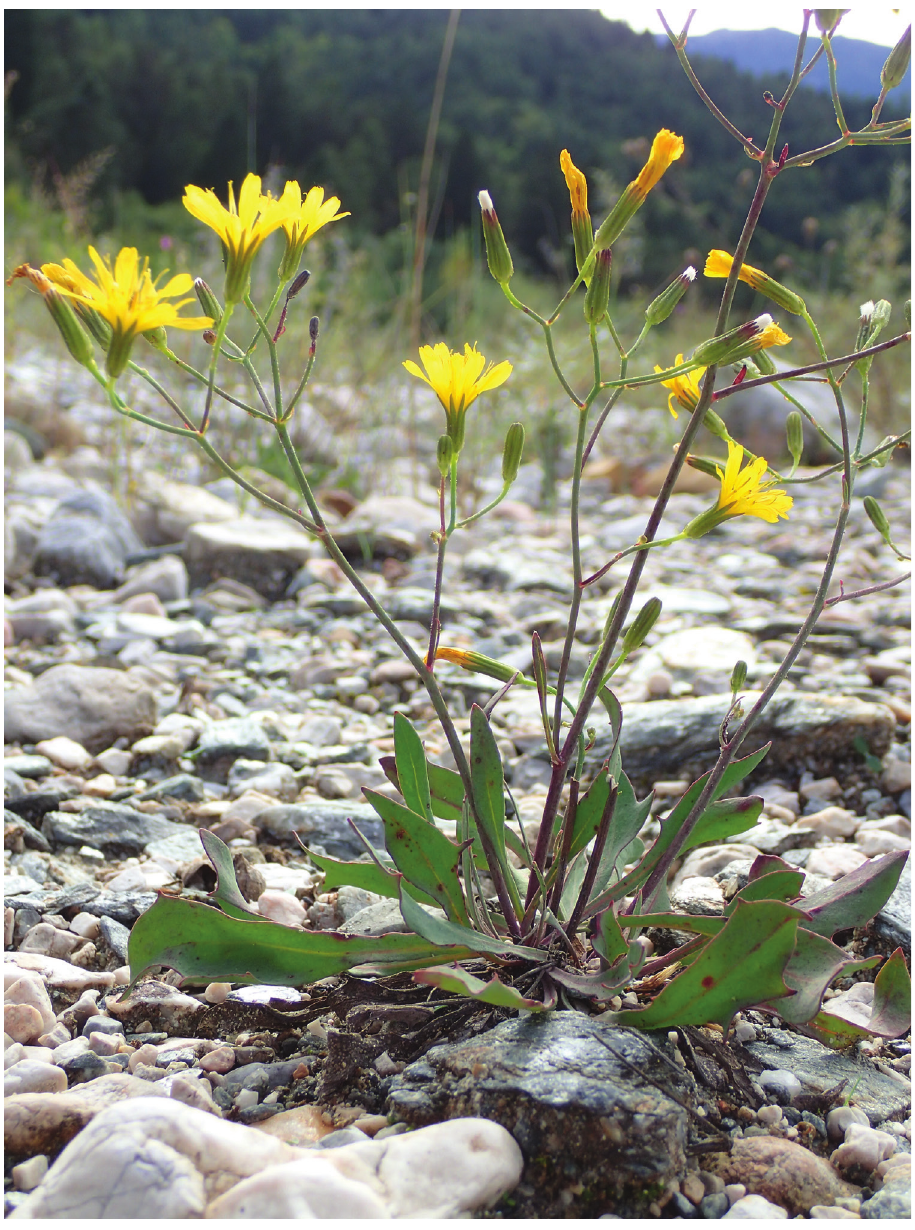
Figure 3. Chondrilla chondrilloides photographed in Caldonazzo (Trento, Italy). Picture by F. Prosser.